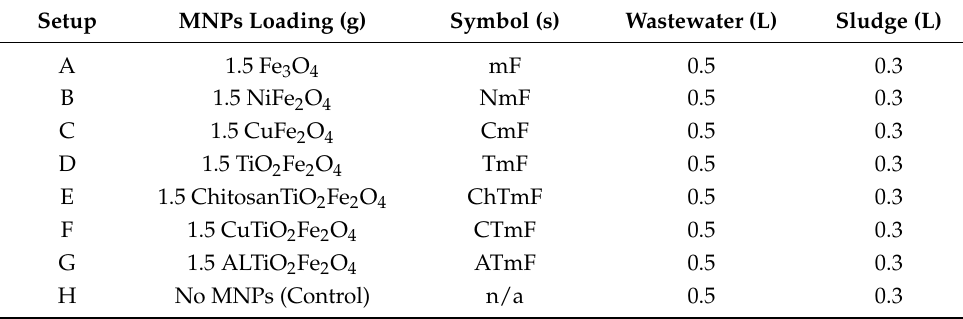
Figure 1. The schematic diagram of the biochemical methane potential (BMP) test setup. Table 2. Experimental matrix for BMP test.